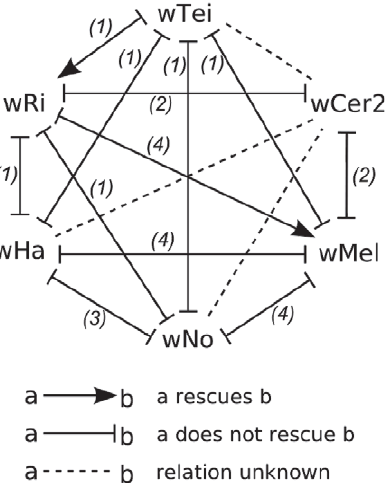
Figure 3. The compatibility relationships of six studied Wolbachia strains. These relationships were used to study whether the goalkeeper-model and the lock-key-model are able to reproduce empirical data. Threshold for CI: corrected CI level of 20%. The host species is D. simulans in all studies. References: (1) [19], (2) [18], (3) [16], (4) [17].